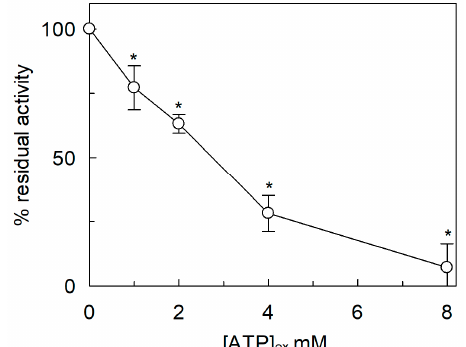
Figure 6. Effect of ATP(Na + ) 2 salt on the transport activity of Sl CAT2 in proteoliposomes. Sl CAT2 was purified and reconstituted in proteoliposomes as described in Section 4.4. Transport was measured in 20 min, as described in Section 4.5, by adding 100 µ M [ 3 H]Arg together with the indicated concentrations of ATP to proteoliposomes containing 200 mM sucrose and 15 mM ATP, at pH 7.5. Transport activity was calculated as the percent of residual activity with respect to condition without any addition (in absence of external ATP). Results are the means ± SD from three experiments. (*), Significantly different, from the control (without ATP in the extraliposomal compartment) for p < 0.05 as calculated from Student’s t -test